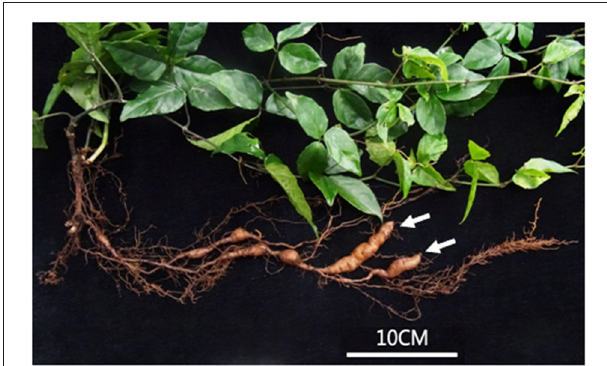
FIGURE 1 | Phenotype of a 28-month-old T. hemsleyanum plant. Arrows indicate fully developed tuberous roots (FD TRs).